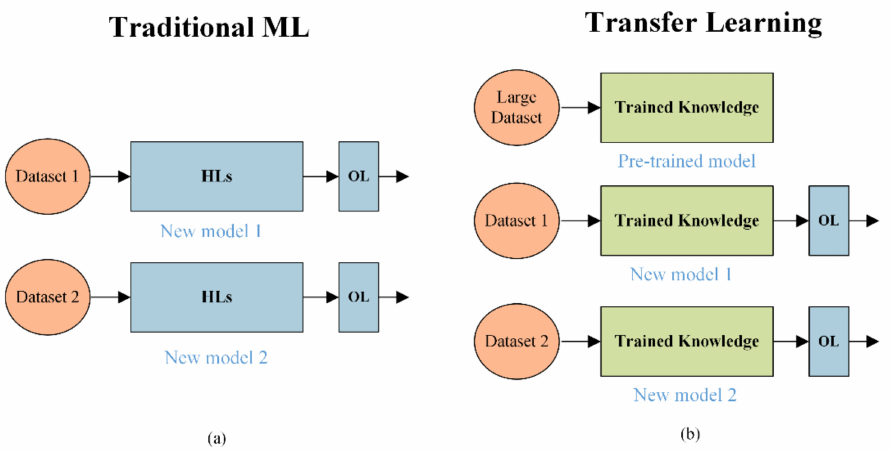
Figure 2. The training mechanisms of deep neural networks (DNNs): ( a ) traditional machine learning (ML) and ( b ) transfer learning.